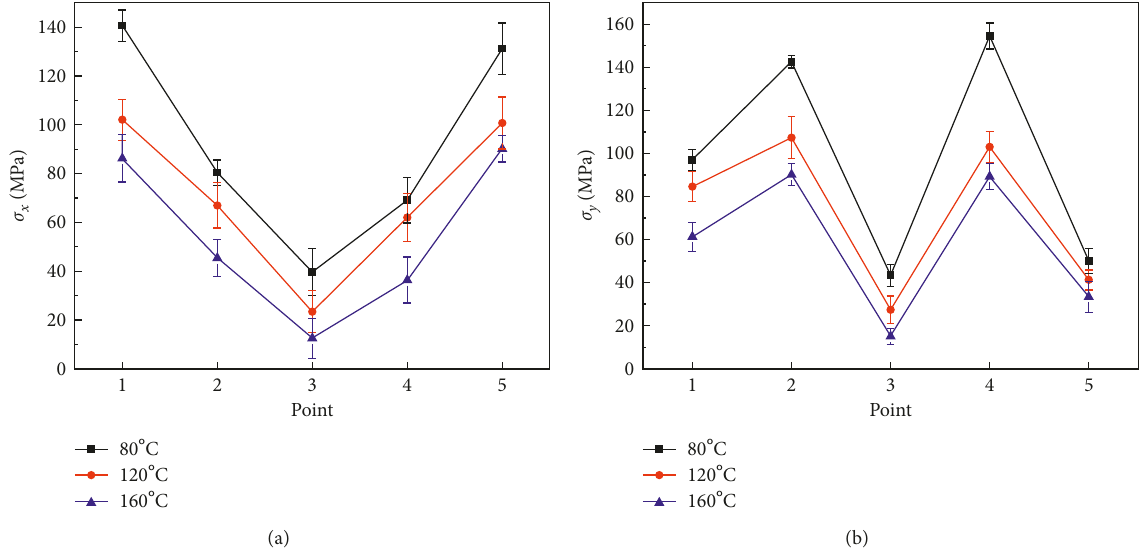
Figure 9: Uniformity scanning. (a) Residual stress in X direction. (b) Residual stress in Y